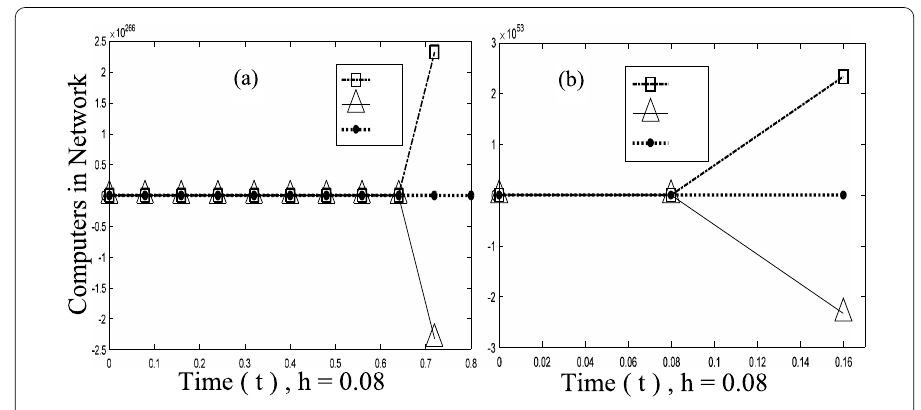
Figure 2 Divergence behaviors of ( a ) Euler method, ( b ) Rk-4 method for VE and h = 0.08